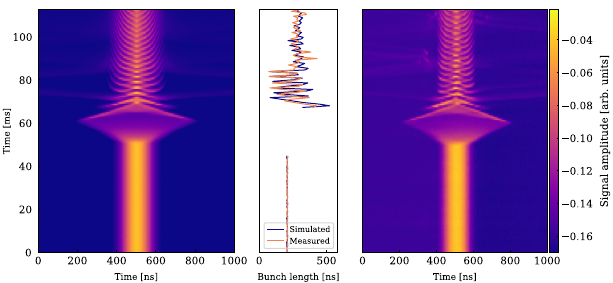
FIG. 3. Left: phase-space area ratio estimate for low relative barrier speeds. Note that at zero barrier speeds the growth per reflection is exactly zero. Right: limiting case of the relative barrier speed at half of the phase velocity of an outer particle in the bunch; on this scale, all curves converge to the singularity = ϕ regardless of the ϕ bucket aspect ratios. d r